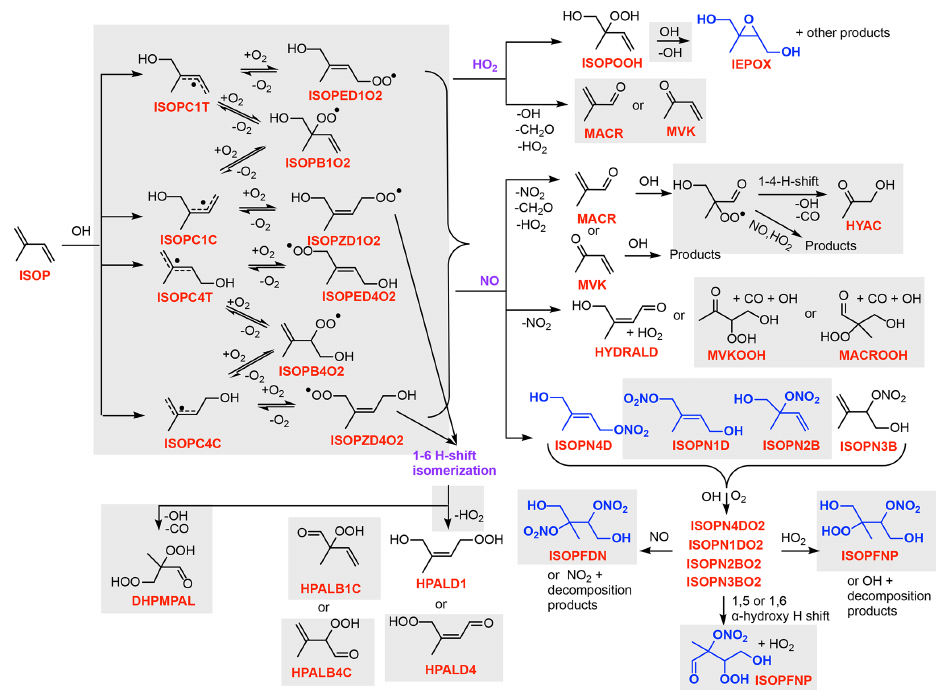
Figure 1. Simplified schematic of the TS2 mechanism for isoprene OH-initiated oxidation. Gray boxes indicate new chemistry added or updated in TS2. Blue compounds undergo aerosol uptake. As shown, only certain isomers of organic nitrates undergo aerosol uptake as explained in Sect. 2.4. All species names used in TS2 are described in Table S2. Similar schematics for NO 3 - and O 3 -initiated oxidation of isoprene are provided in Figs. S1 and S3 in the